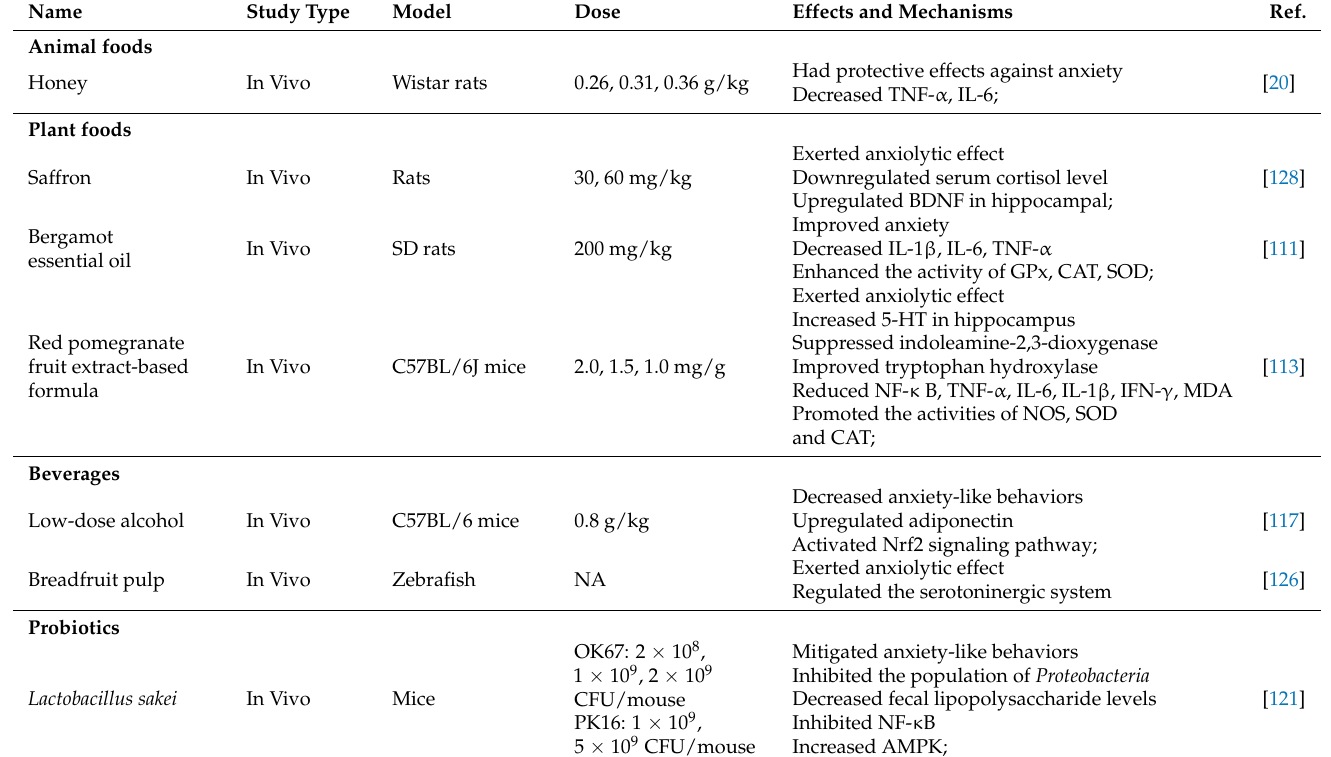
Table 4. Effects and mechanisms of dietary natural products and nutrients on anxiety from experi- mental